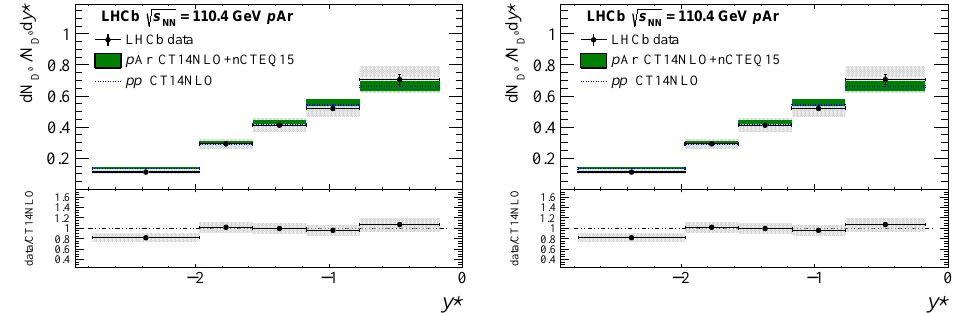
Figure 4: Measured D 0 rapidity distributions in fixed target p He (left) and p Ar col- lisions [ 23 ] . The error bars show the statistical and uncorrelated systematic uncer- tainties, and the gray shaded region shows the correlated systematic